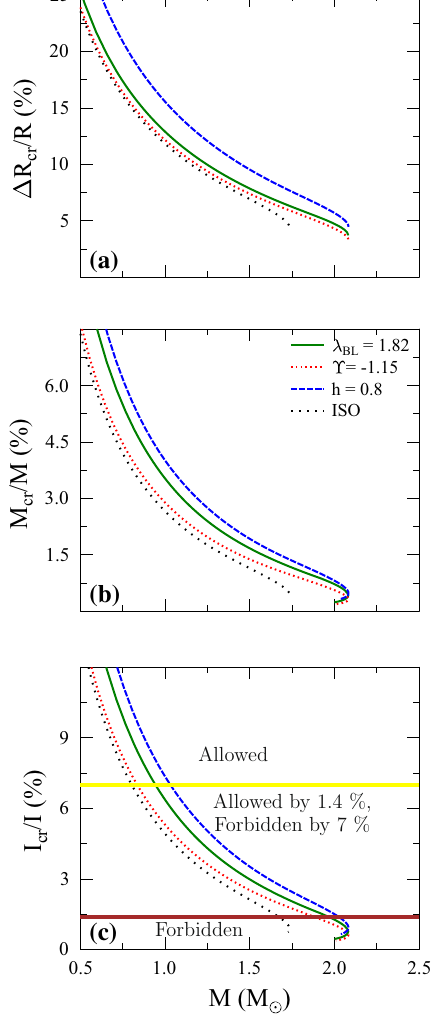
Fig. 9 Impact of anisotropic pressure on the crust properties. a The ratio of the crust to core radius as a function of NS mass, b the ratio of crust to core mass as a function of NS mass, and c the ratio of crust to core inertia moment of NS with hyperons as a function of NS mass. For comparison, we include the horizontal lines in c I cr / I constraint deduced from Vela pulsar with canonical mass (see Ref. [28] and